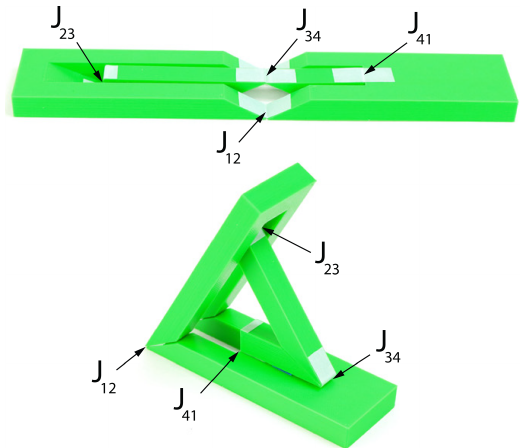
Figure 3. Example of a planar deploying strut ThUDS with joints J 34 and J 41 on the top surface and joints J 12 and J 23 on the bottom surface. Shown in flat and deployed states. Joint names shown for reference.